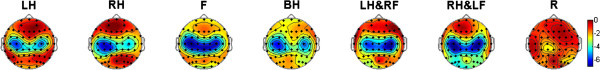
The topographical distribution for 7 mental tasks from one subject. The maps are made based on ERSP values of each electrode. Blue regions indicate the involved areas when ERD occurs during mental tasks.